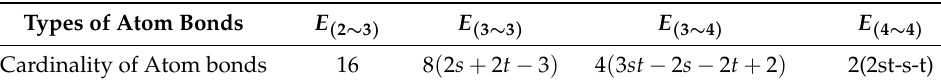
Table 1. Atom-bond partition of NbO 2